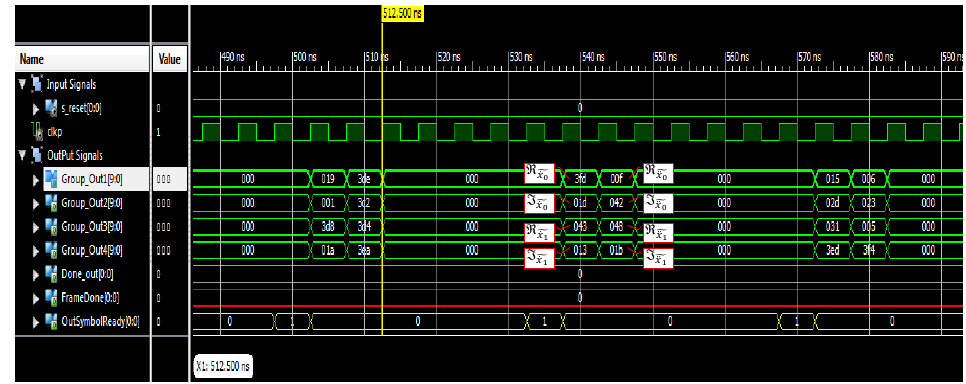
Figure 11. Xilinx ISE simulation window showing equalizer architecture output